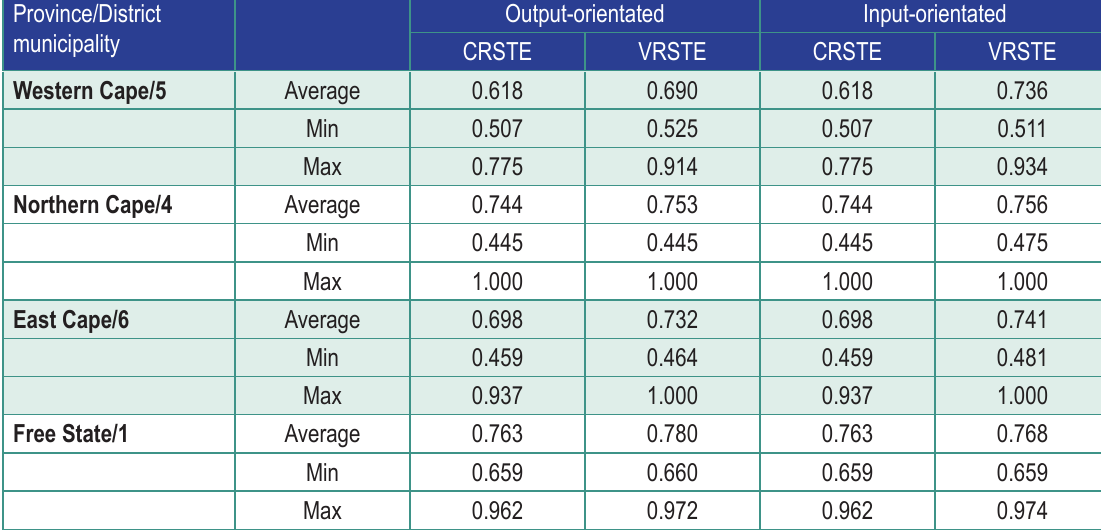
Table 2: Best-Performing District Municipality per